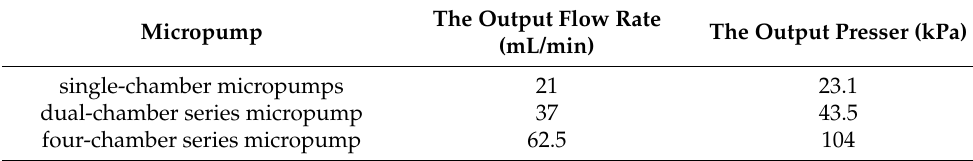
Table 2. The output performance of single-, dual-, and four-chamber micropumps.